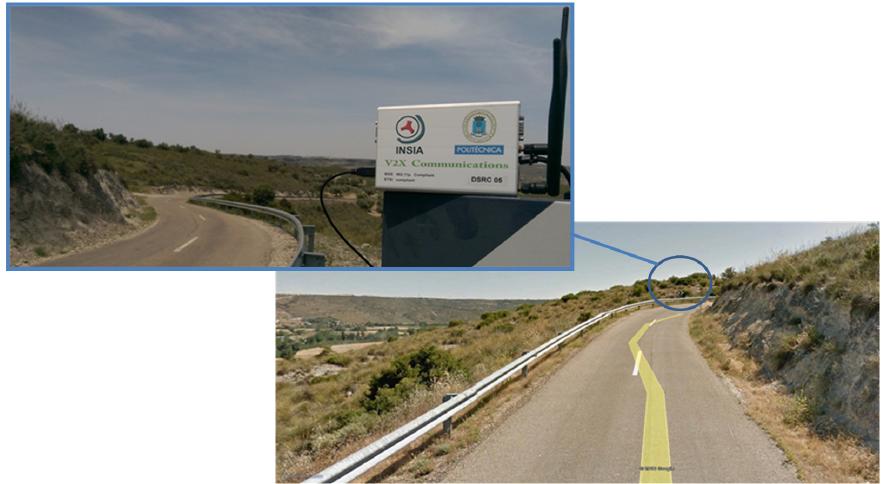
Figure 4. Bend of the winding road where the Roadside Unit (RSU) was placed.